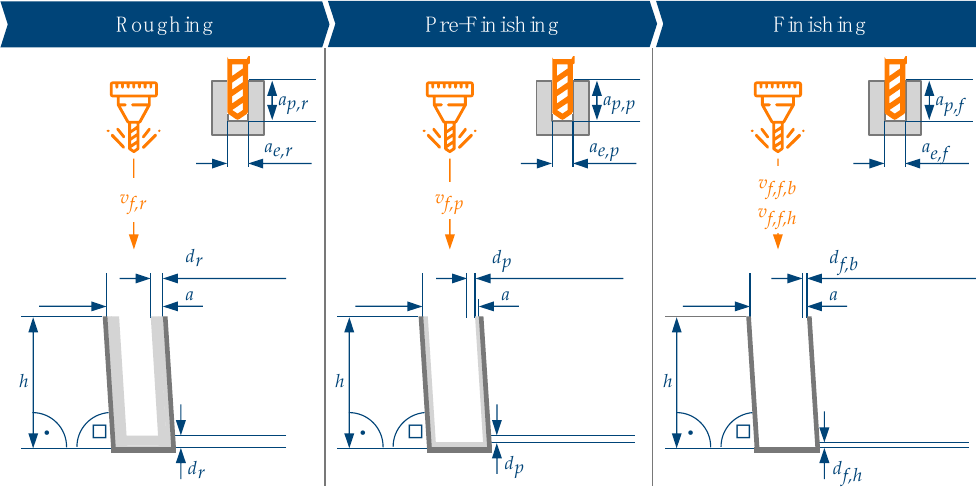
Figure 10. Configurable processing steps of milling machine producing BLISKs representing its control tasks.